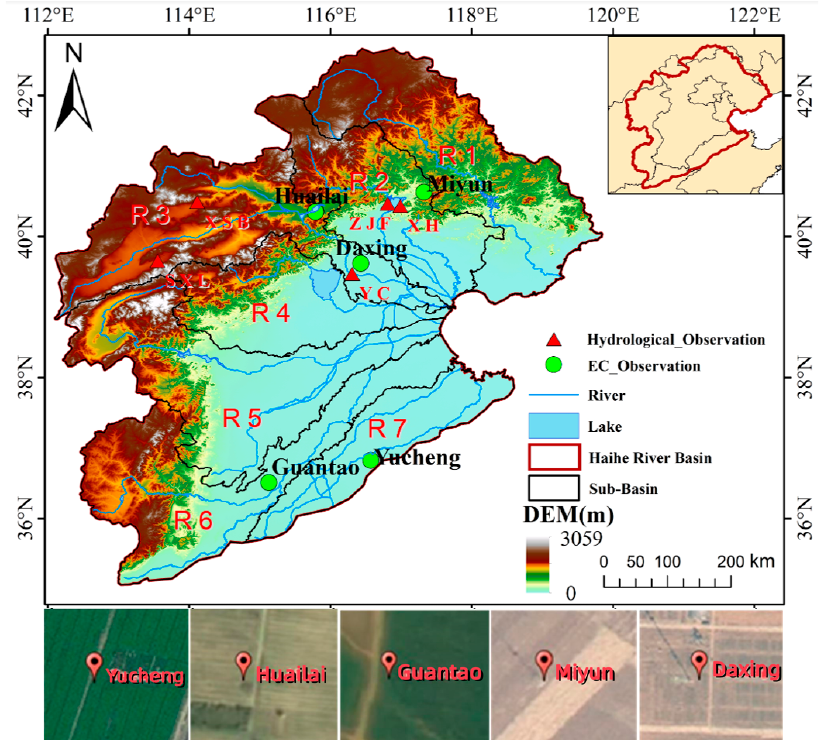
Figure 1. Study area: locations of the seven sub-basins and five EC observation sites. The DEM was derived from the Shuttle Radar Topography Mission (SRTM) elevation model. The lakes and rivers are shown in the figure. The green dots show the locations of the eddy co-variance (EC) flux towers, which were used for the ET validation. The red triangles show the location of the hydrological observation stations, which were used for the LORA validation.